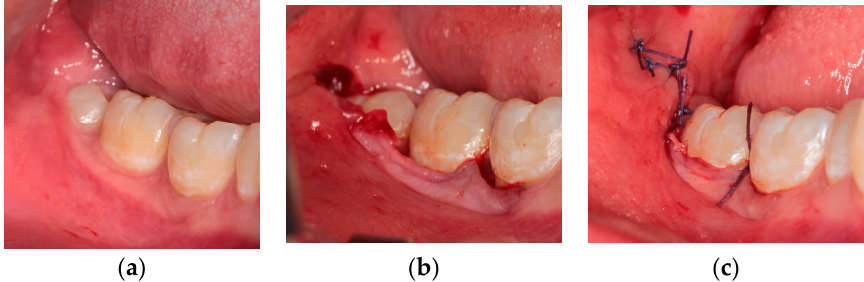
Figure 3. Flap with papilla detachment: ( a ) pre ‐ operative clinical view; ( b ) intra ‐ operative incisions; ( c ) final suture.